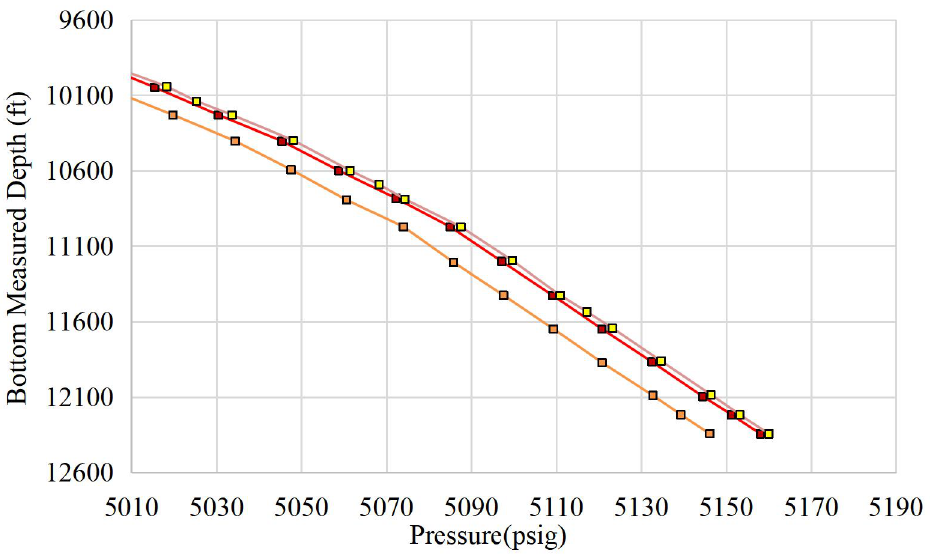
Figure 14—Using PDHG data for Best Fit Correlation.